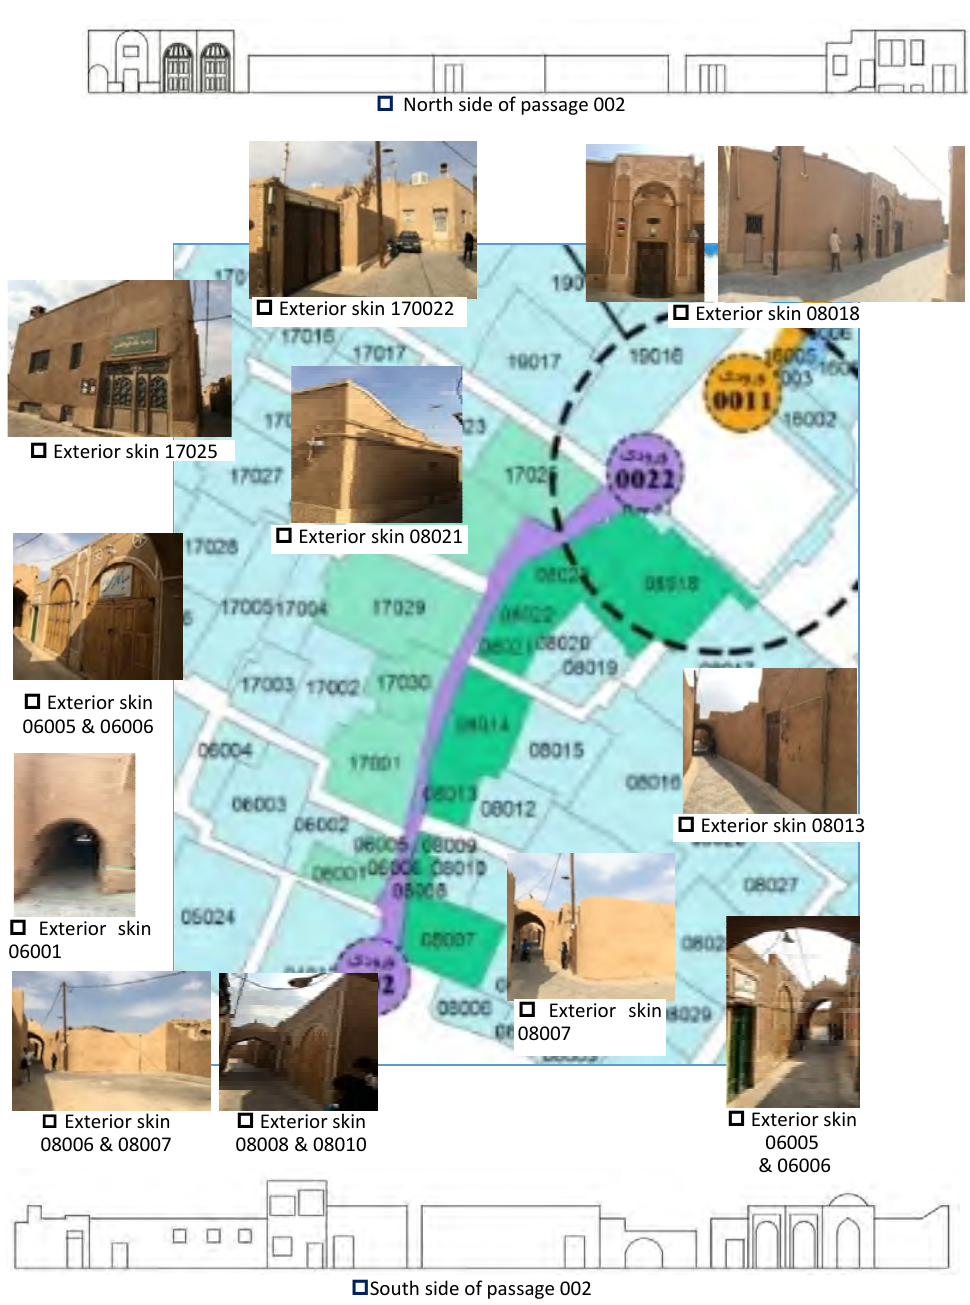
Fig. 6: Passage exterior skin of 002 Shah Abolghasem district of Yazd